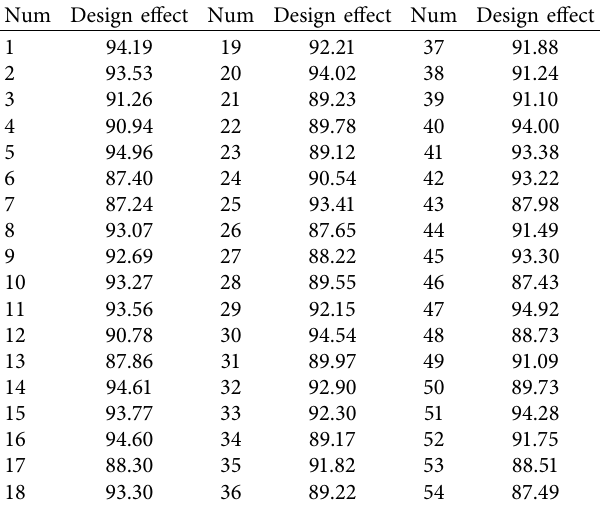
Table 2: Environmental landscape design effects. Num Design effect Num Design effect Num Design